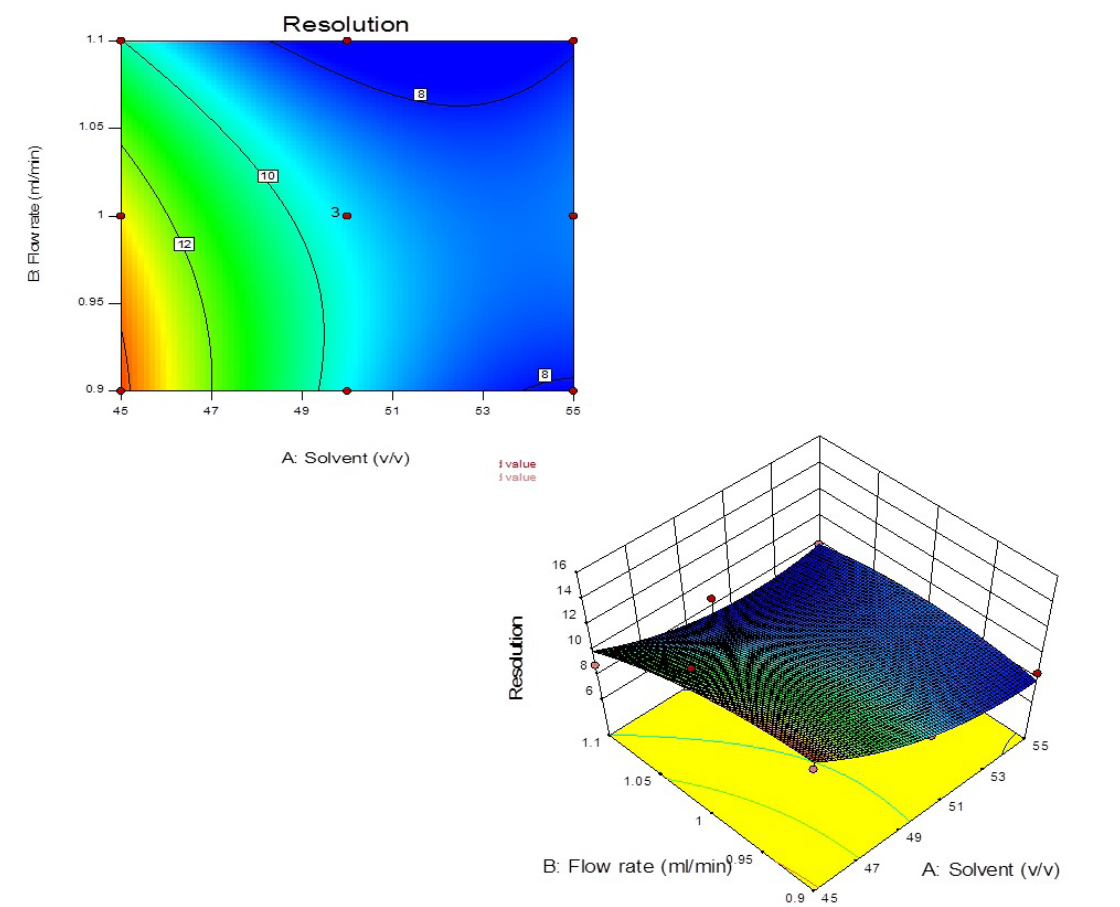
FIGURE 5 - 2D (A) and 3D (B) contour plots showing the effect of mobile phase ratio (X